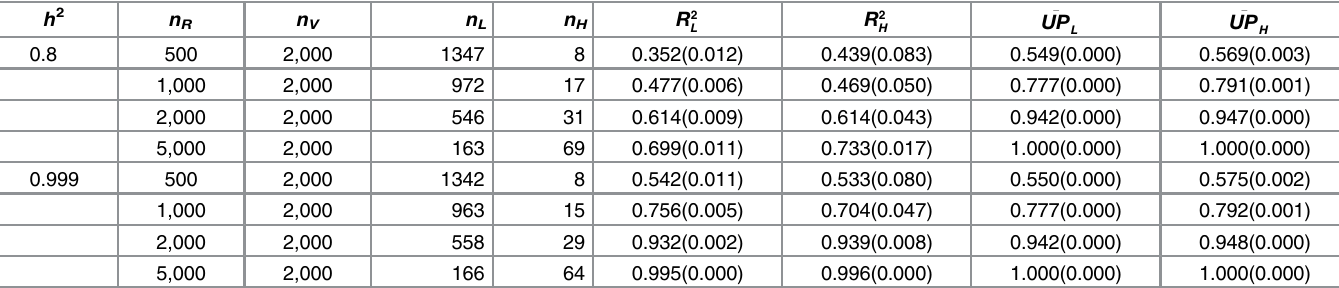
Table 5. Predictive accuracies and estimabilities for relationship